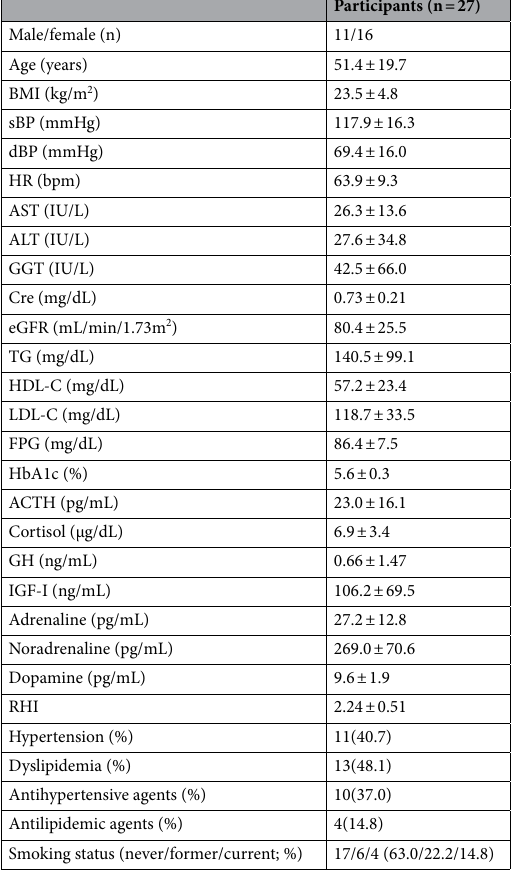
Table 1. Baseline clinical characteristics of the study participants. Data are mean ± standard deviation, or n (%). BMI, body mass index; sBP, systolic blood pressure; dBP, diastolic blood pressure; HR, heart rate; AST, aspartate transaminase; ALT, alanine transaminase; GGT, gamma-glutamyl transferase; Cre, creatinine; eGFR, estimated glomerular filtration rate; TG, triglyceride; HDL-C, high-density lipoprotein cholesterol; LDL-C, low-density lipoprotein cholesterol; FPG, fasting plasma glucose; HbA1c, glycated hemoglobin, GH, growth hormone; IGF-1, insulin-like growth factor-1; ACTH, adrenocorticotropic hormone; RHI, reactive hyperemia peripheral arterial tonometry index.